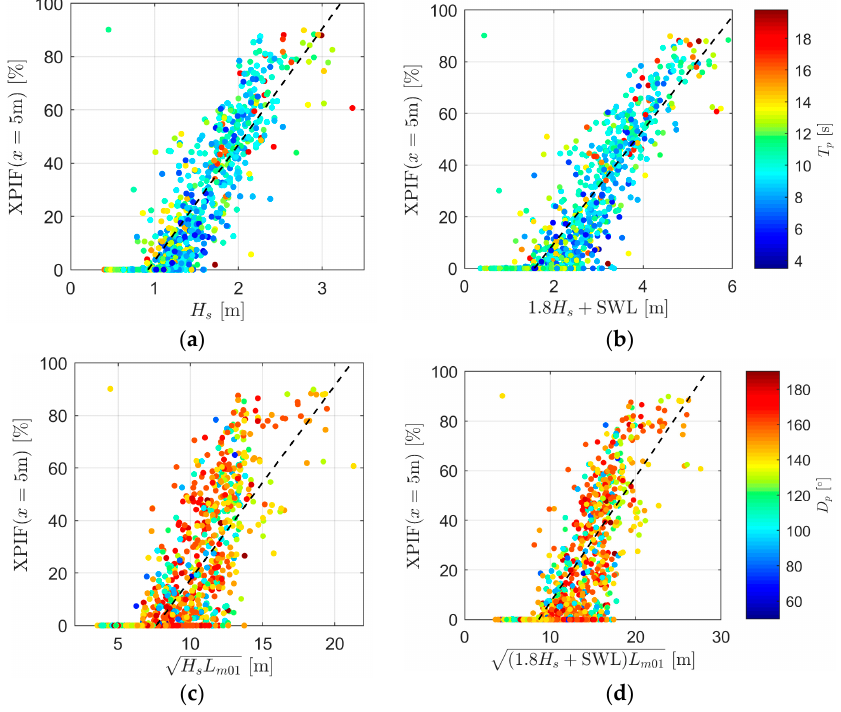
Figure 11. Comparison inundation on the platform at x = 5 m on transect N2 (see Figure 2 for location) with: ( a ) significant wave height ( H s ); ( b ) H s plus tidal still water level (1.8 H s + SWL); ( c ) square root of significant wave height times wavelength derived from the spectral mean wave period ( (cid:3493)(cid:1834) (cid:3046) (cid:1838) (cid:3040)(cid:2868)(cid:2869) ); and ( d ) (cid:3493)(1.8 (cid:1834) (cid:3046) + SWL)(cid:1838) (cid:3040)(cid:2868)(cid:2869) . The points in panels ( a , b ) are colored by peak wave period (see color bar in panel ( b )). The points in panels ( c , d ) are colored by peak wave direction (see color bar in panel ( d )). Linear regression lines calculated using data with XPIF ≥ 1% are show in each panel and correspond to: ( a ) XPIF = 43.5(cid:1834) (cid:3046) − 40.1 , R 2 = 0.69; ( b ) XPIF = 22.0(1.8(cid:1834) (cid:3046) + SWL) − 34.4 , R 2 = 0.70; ( c ) XPIF = 6.8(cid:3493)(cid:1834) (cid:3046) (cid:1838) (cid:3040)(cid:2868)(cid:2869) − 43.7 , R 2 = 0.46; ( d ) XPIF = 6.2(cid:3493)(1.8(cid:1834) (cid:3046) + SWL)(cid:1838) (cid:3040)(cid:2868)(cid:2869) − 36.6 , R 2 = 0.48. All linear regression equations have p < 0.001.